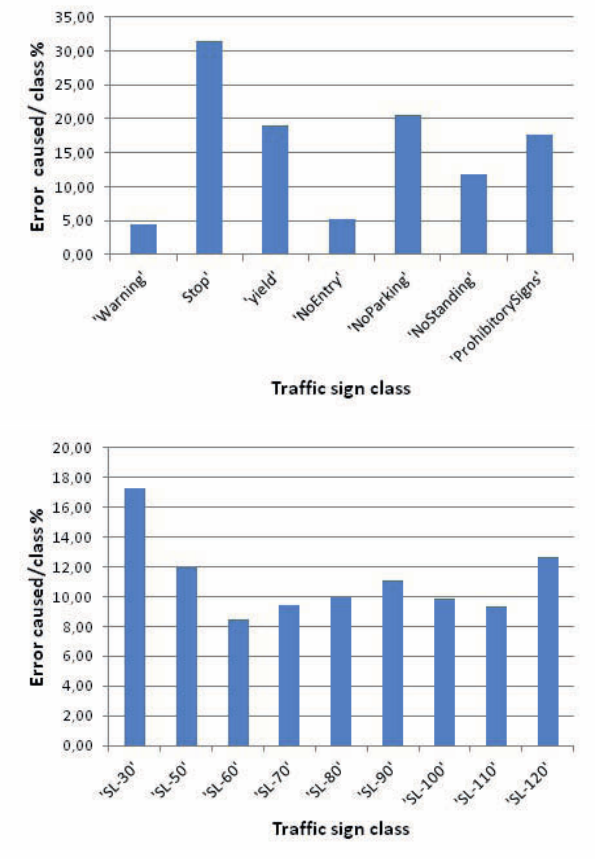
Figure 8. Error Percentage per class. Top: traffic signs’ borders. Bottom: speed limit